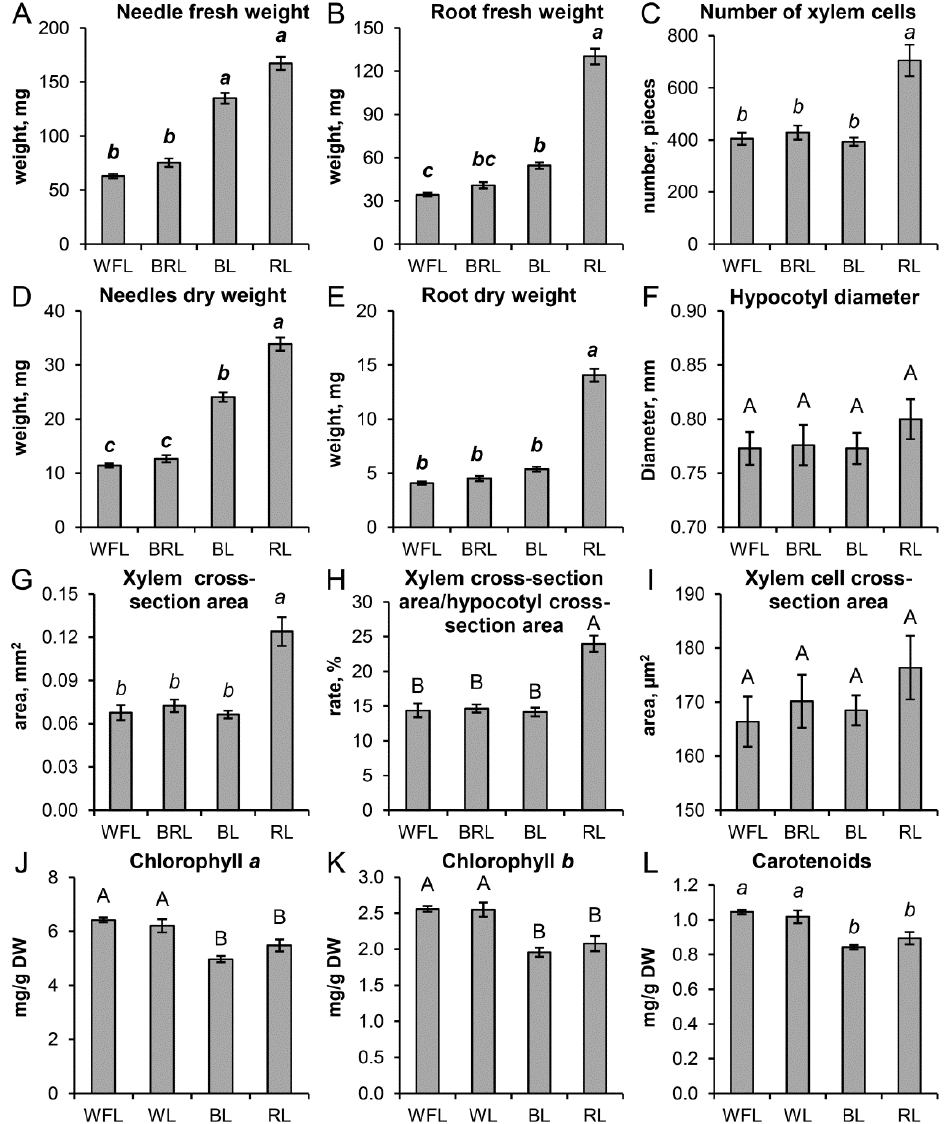
Figure 3. Effect of light quality on the needle ( A ) and root ( B ) fresh weight (mg); number of xylem cells ( C ) (pieces); needle ( D ) and root ( E ) dry weight (mg, DW); hypocotyl diameter ( F ) (mm); xylem cross-section area ( G ) (mm); xylem cross-section area and hypocotyls cross-section area ratio ( H ) (%); xylem cell cross-section area ( I ) (µm 2 ); and content of Chl a ( J ) mg/g DW, Chl b ( K ) mg/g DW, and total carotenoids ( L ) mg/g DW in P. sylvestris seedlings. Values are the mean ± SE. Different capital letters denote statistically significant differences in the means at p < 0.05 (ANOVA fol- lowed by Duncan ’ s method). Different italic letters denote statistically significant differences in the means at p < 0.05 (Kruskal – Wallis ANOVA of the ranks followed by the Student-Newman- Keuls post hoc test). Different boldface italic letters denote statistically significant differences in the means at p < 0.05 (Kruskal – Wallis ANOVA of the ranks followed by the Dun n’s method).